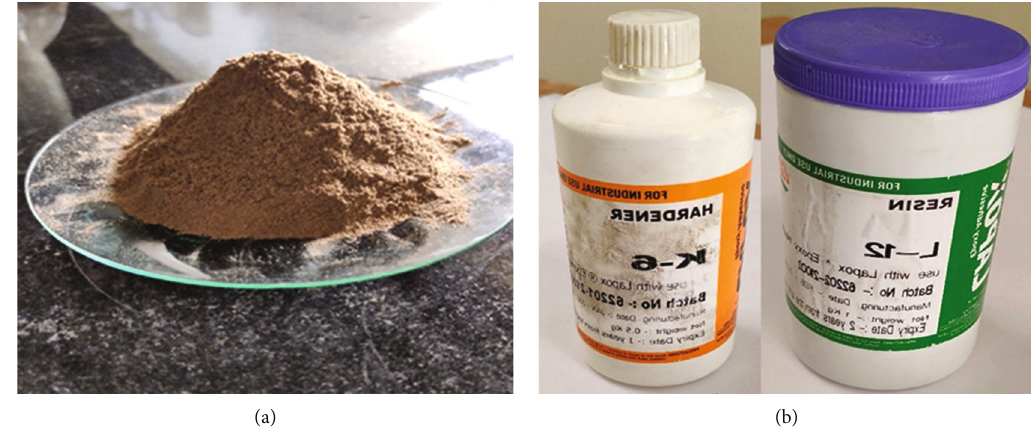
Figure 1: (a) Particulate form of mango seed shell. (b) Epoxy resin and hardener used for composite preparation.